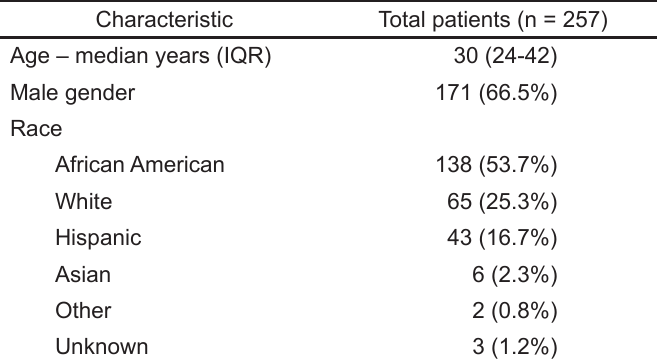
Table 1. Characteristics of patients receiving midazolam for behavioral emergencies.